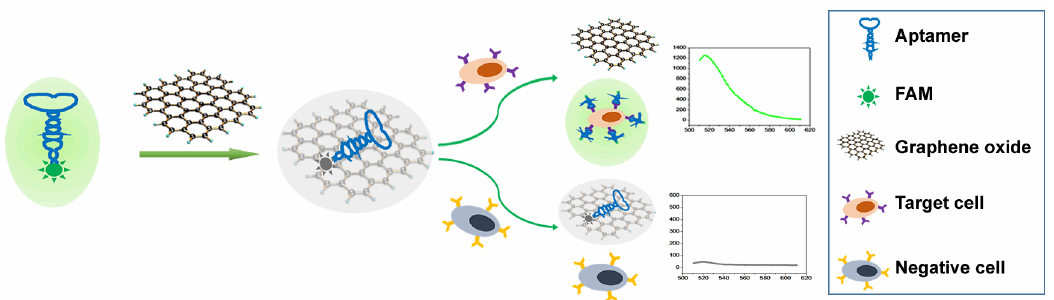
Scheme 1. Schematic illustration represents the working principle of the GO-based fluorescent aptasensor assay.